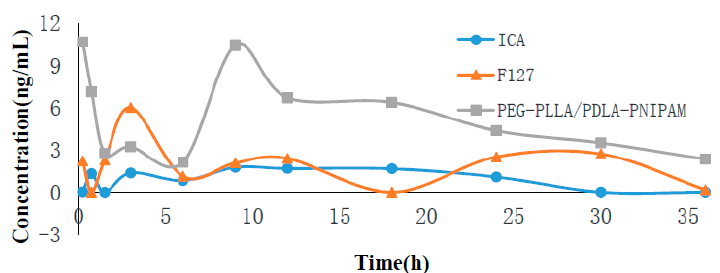
Figure 7. Icariin (ICA) concentration versus time after oral of different drug formulations ( n = 3). Table 3. Pharmacokinetic parameters.